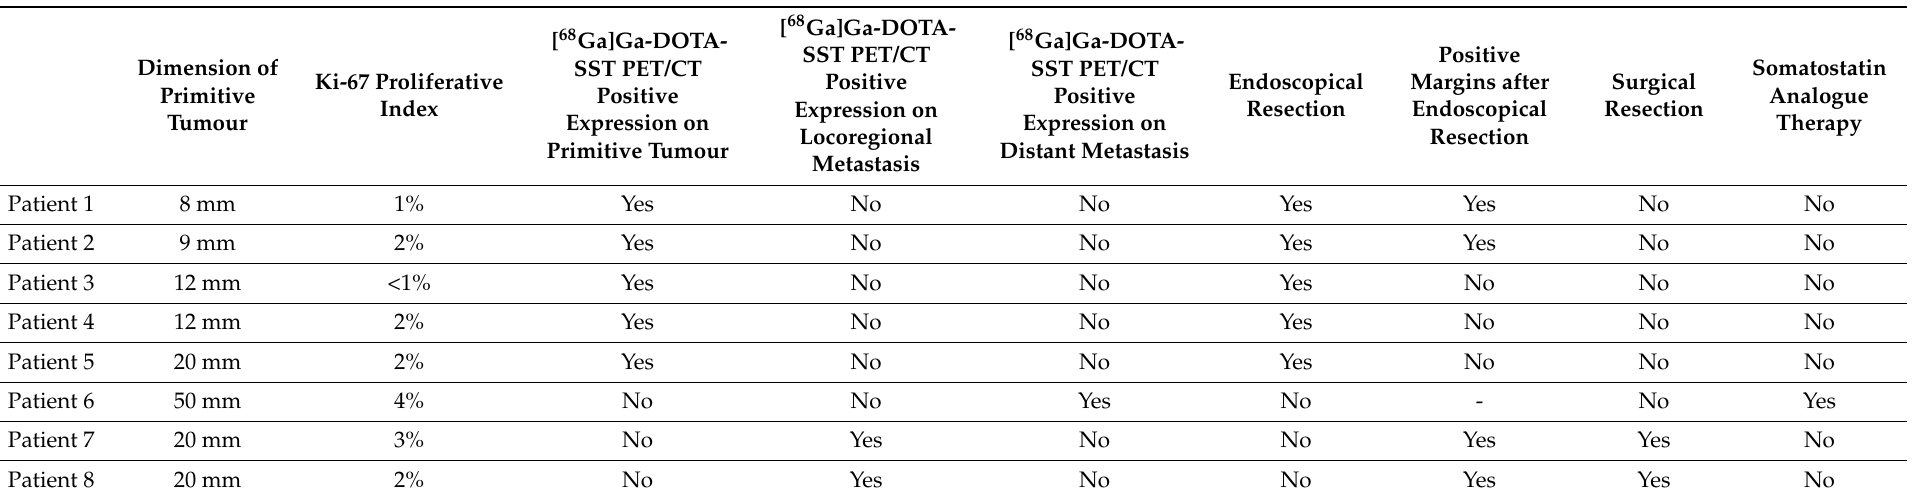
Table 2. Patient characteristic with [ 68 Ga]Ga-DOTA-SST PET/CT positive